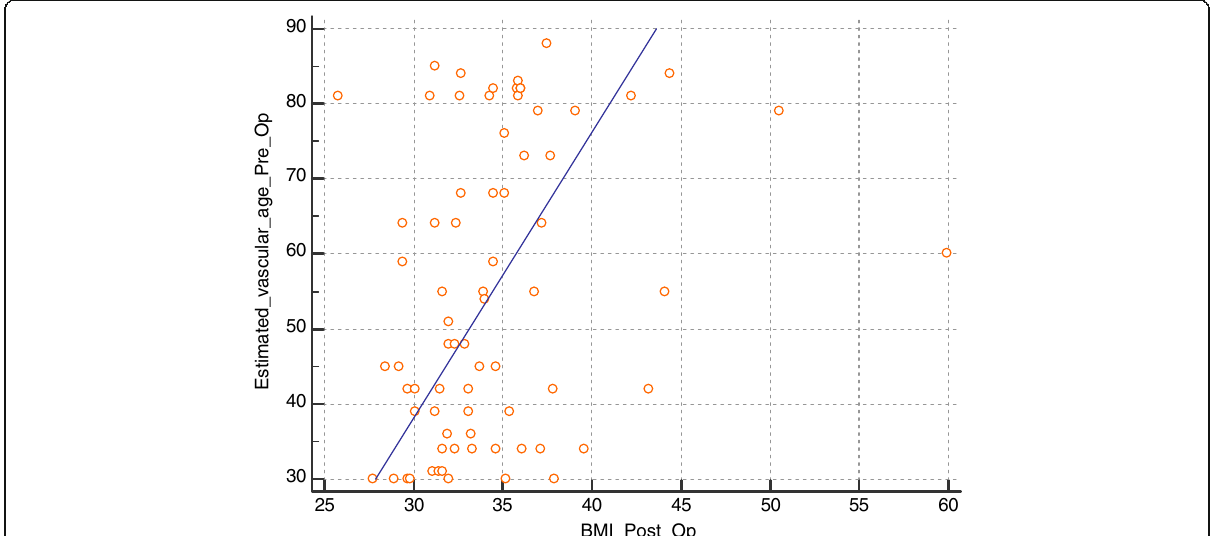
Fig. 3 Correlation between postoperative BMI and preoperative estimated vascular age